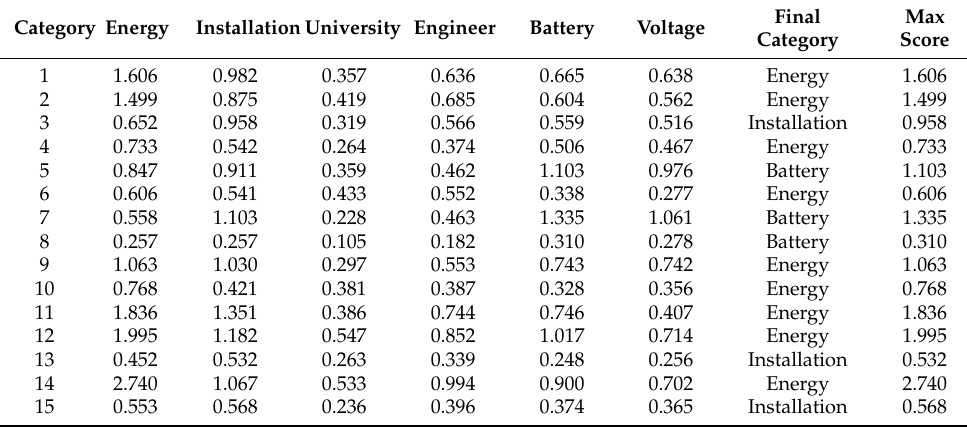
Table 6. Selection of question scores for each category.